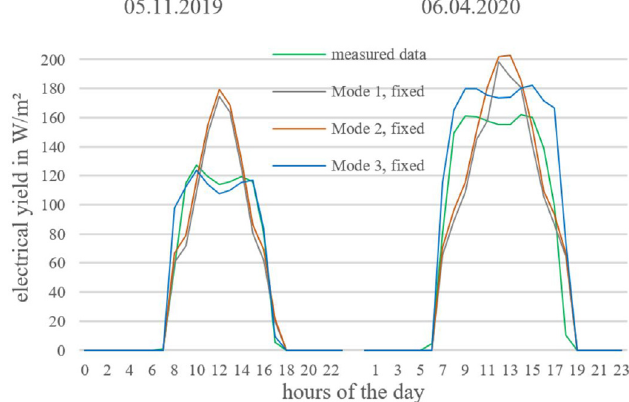
Fig. 4. The fi gure compares the electrical yield of measured data to the simulation data on the days 05.11.2019 and 06.04.2020. Simulation mode 3 (RT) follows the measured data closely over the course of the day. Small deviations can be found, which may be attributed to the lack of consideration of mismatching losses. The overall relative deviation is (cid:2) 6.5%. The VF based simulation Mode 1 and 2 show a different trend, with a peak in midday hours and negative deviations in morning and evening hours. This development resembles the course of GHI over the day. The purely VF based simulation mode 2 produces consistently higher energy yields than the VF/RT combination mode 1.